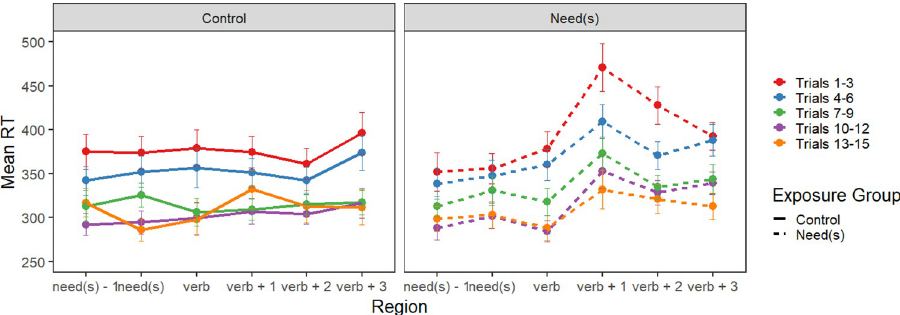
Fig 6. Experiment 3 exposure block. Mean reading times for critical sentence regions by trial number grouped in bins of 3 trials. Data from the control group are plotted on the left, while that from the needs exposure group are plotted on the